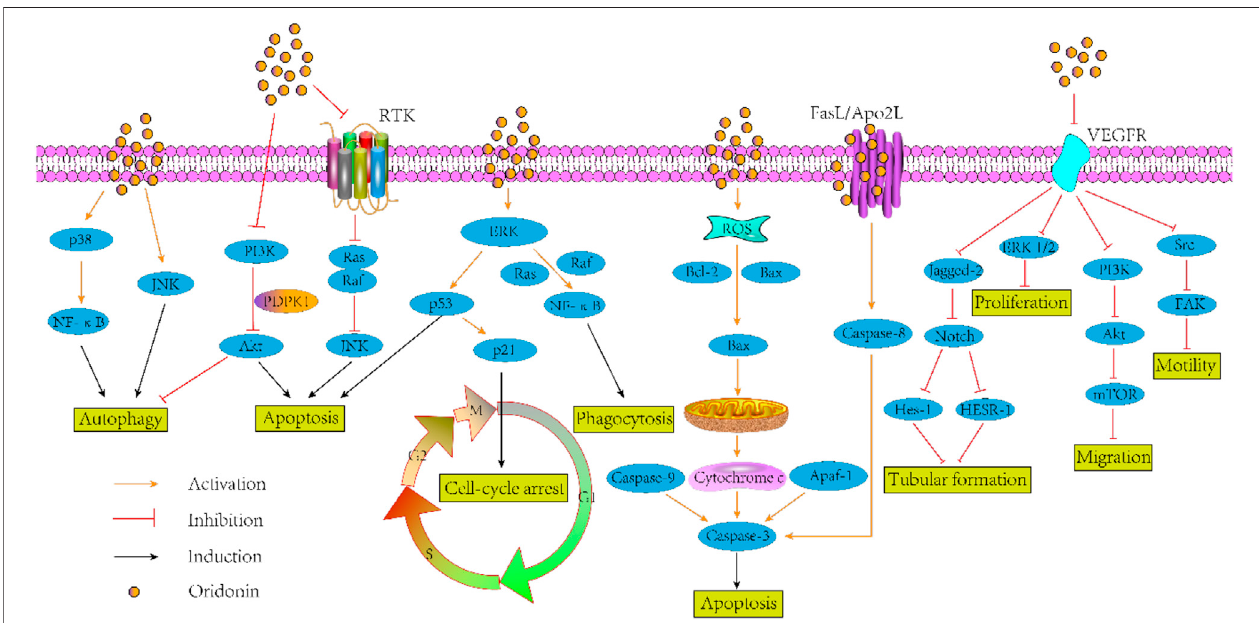
FIGURE 2 | The antitumor mechanism of